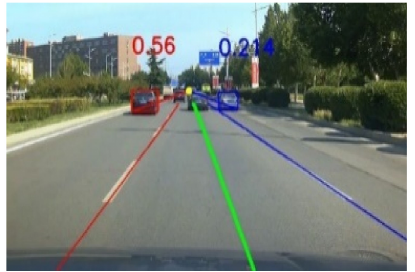
Figure 19. Diagram of lane corner and angle a